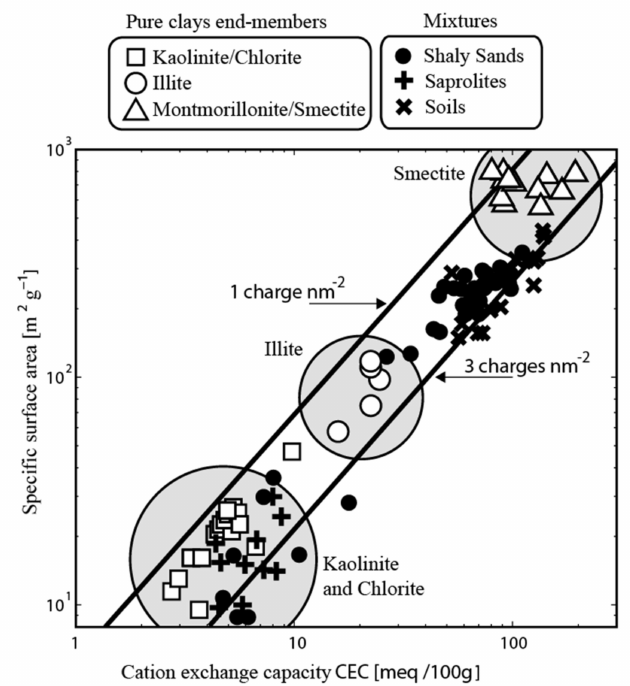
Figure 2. Specific surface area versus cation exchange capacity (expressed in meq g − 1 with 1 meq g − 1 = 96,320 C kg − 1 ) for the main clay minerals. The ratio between the CEC and the spe- cific surface area corresponds to the charge density at the surface of the minerals. The two lines correspond to a surface charge density of 1 to 3 elementary charges per unit surface area. Smectite has the highest CEC of all clay minerals and its production through alteration in geothermal system can control the CEC of the mineral assemblage. The soil data are from Chittoori and Puppala [57]. Data for the clay end-members are from Patchett [58], Lipsicas [59], Zundel and Siffert [60], Lock- hart [61], Sinitsyn et al. [62], Avena and De Pauli [63], Shainberg et al. [64], Su et al. [65], and Ma and Eggleton [66]. The saprolite data are from Revil